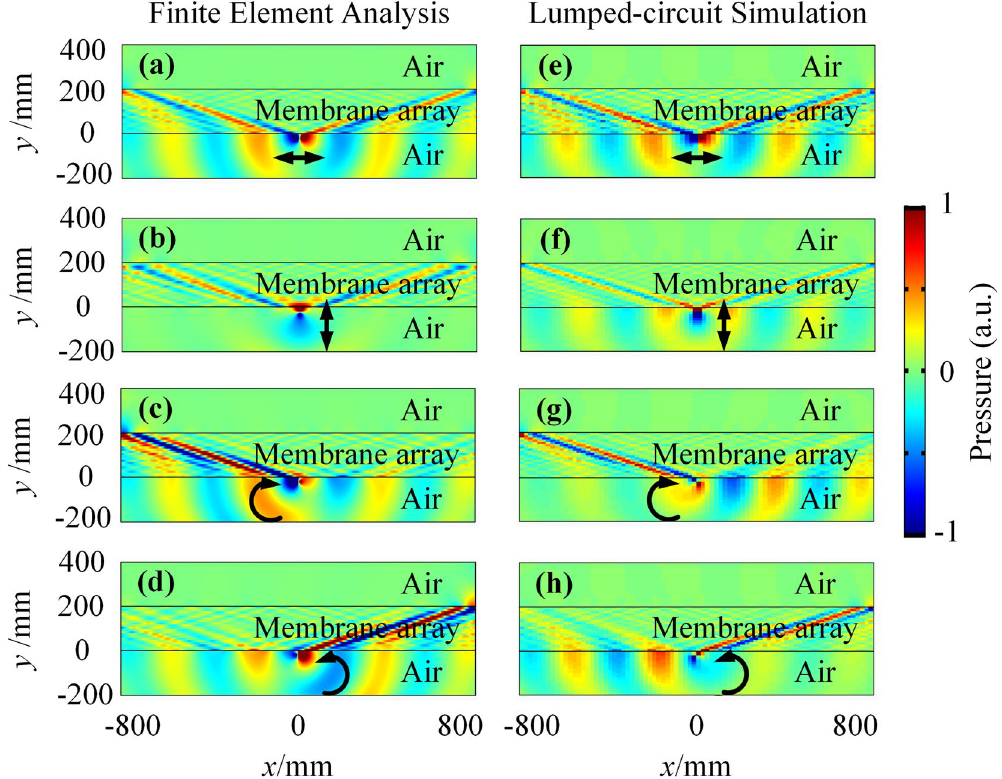
Figure 4. ASHE in the membrane-type AHMM. The pressure field excited by (a) the acoustic horizontal dipole = p [1, 0] , (b) the acoustic vertical dipole = p [0, 1] , (c) the acoustic clockwise helical wave emitter p i [1, ] = and (d) the acoustic counterclockwise helical wave emitter p i [1, ] = − situated in the near-field of the membrane-type AHMM. (e–h) Corresponding lumped-circuit simulation results (See Supplementary Movie